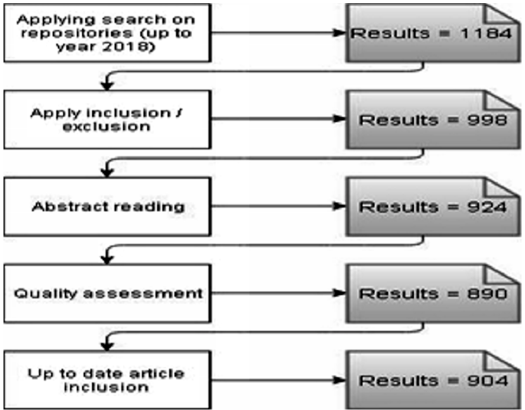
Figure 2. Number of included papers during study selection process.